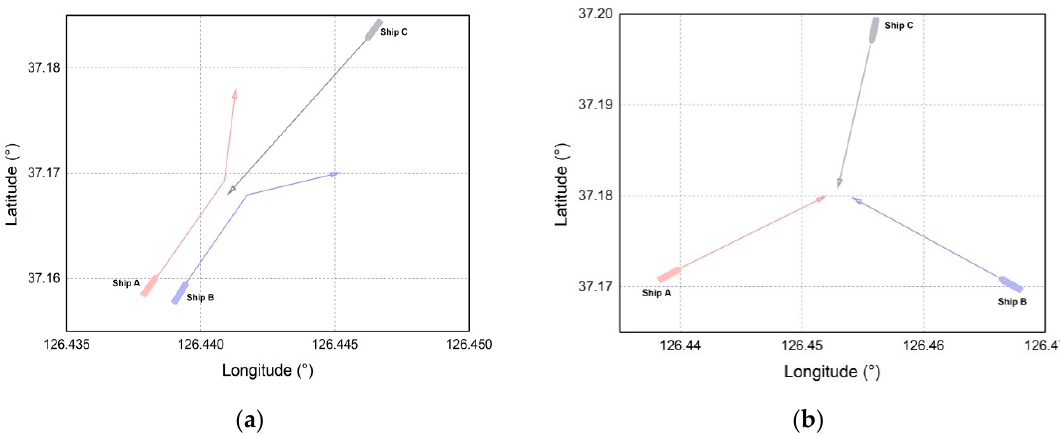
Figure 4. ( a ) Scenario 1: ships A and B sail in parallel at a course of ~045° while ship C sails from the opposite direction at ~225° and ( b ) scenario 2: ship A sails at the course of ~045°, ship B at ~315°, and ship C at ~180°, approaching a single location.